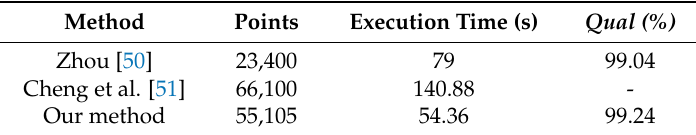
Table 6. Comparison of execution time results based on the fandisk model.